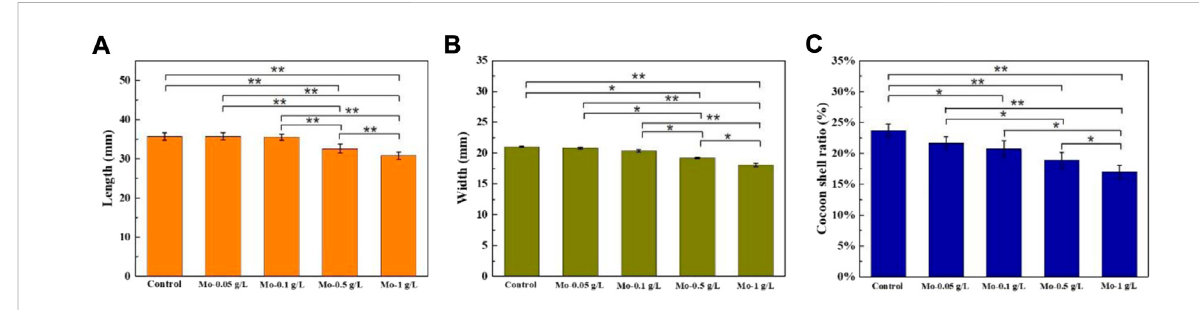
In addition to PSG, adverse effects caused by feeding silkworms high dosages of AMT were apparent in the anterior and middle silk glands, as shown in Supplementary Figure S6. The results indicate that feeding silkworms with a high dosage of AMT suppressed silk gland